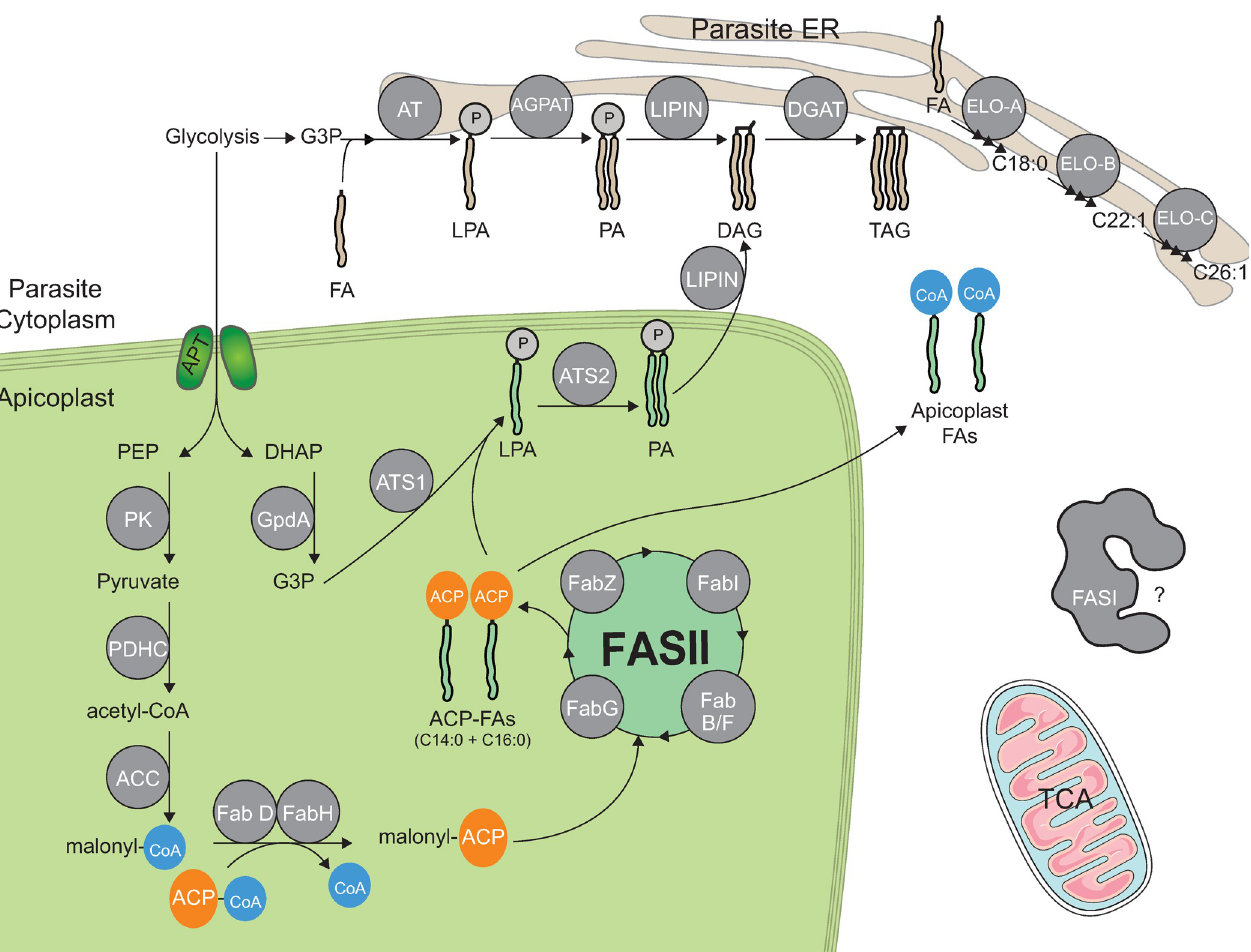
Fig 2. An illustration of the known proteins involved in glycerolipid synthesis in Apicomplexa parasites. PEP and DHAP generated from glycolysis occurring in the cytosol of the parasites enter the apicoplast via the apicoplast phosphate transporter ( Tg APT1). They are then converted to pyruvate and G3P by a PK and GpdA, respectively. A PDHC (only present in the apicoplast [91]) is responsible for the formation of acetyl-CoA from pyruvate. ACC converts this to malonyl CoA. FabD/H complex leads to the attachment of an ACP and the loss of CoA resulting in ACP-malonyl. The FASII complex (comprised of FabG/ B/F/I/Z) are responsible for the formation of short FA chains, mainly C14:0 and C16:0 fatty acyl (FA) ACP-chains. Esterification of FA-ACP from FASII or FA-CoAs from scavenged FAs on a G3P backbone (i.e., acylation) can occur in both the apicoplast by a plant-like acyltransferase Tg ATS1 [5], and/or at the ER by a GPAT [93]. It is the first step for the de novo synthesis of all glycerolipids and results in the synthesis of LPA. LPA can be further acylated with another FA chain resulting in PA by ATS2-apicoplast or AGPAT-based ER [6]. LIPIN is responsible for the dephosphorylation of PA into DAG [39]. DAG can be further acylated into TAG by DGATs [94]. Elongation of FA chains can occur in the elongation pathway in the ER via ELO-A/B/C [16]. FASI is present in T . gondii parasite and not essential during tachyzoite stages and has not been further characterized [15]. ACC, acetyl-CoA carboxylase; ACP, acyl-carrier protein; DAG, diacylglycerol; DGAT, DAG acyltransferase; DHAP, dihydroxyacetone phosphate; FA, fatty acid; GpdA, glyceraldehyde-3-phosphate dehydrogenase; G3P, glycerol-3-phosphate; LPA, lysophosphatidic acid; PA, phosphatidic acid; PDHC, pyruvate dehydrogenase complex; PEP, phosphoenolpyruvate; PK, pyruvate kinase; TAG,